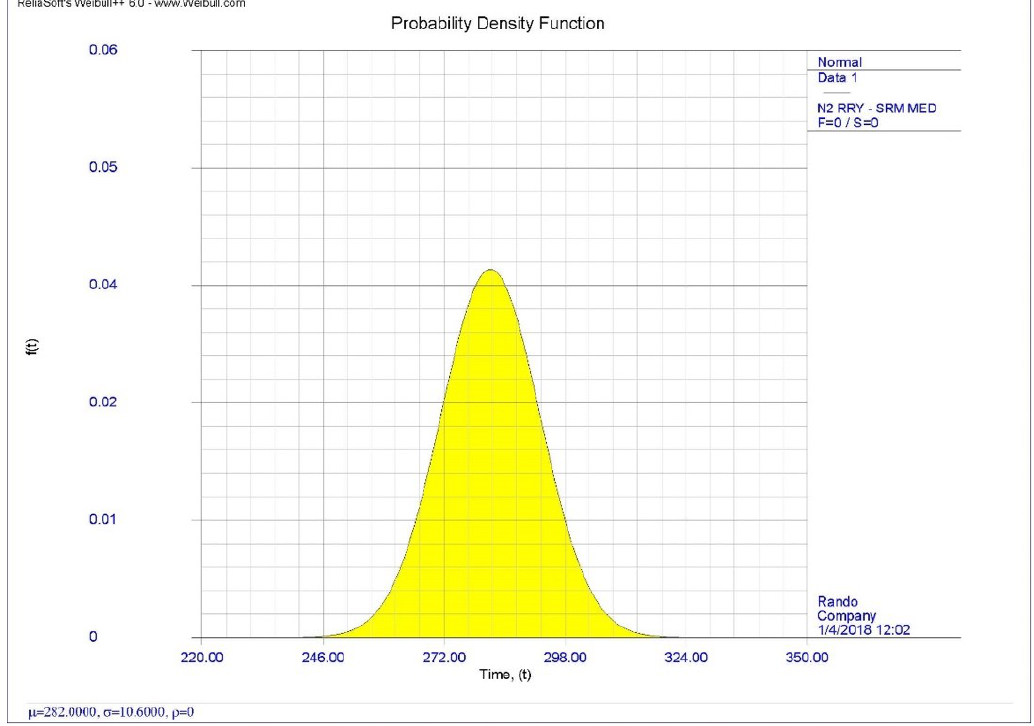
Figure 6: Probability density function of mean fatigue strength of tested material.